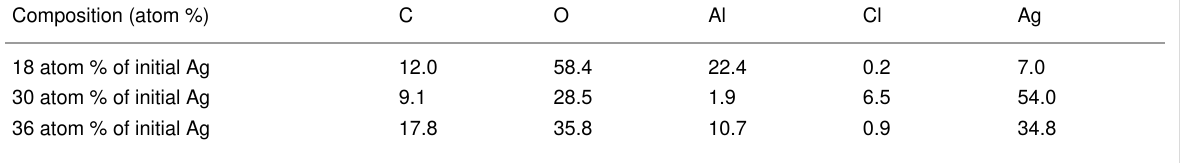
Table 1: Surface composition evaluated by XPS of samples dealloyed for 60 min in 1 wt % HCl for different initial Ag content. Composition (atom %) C O